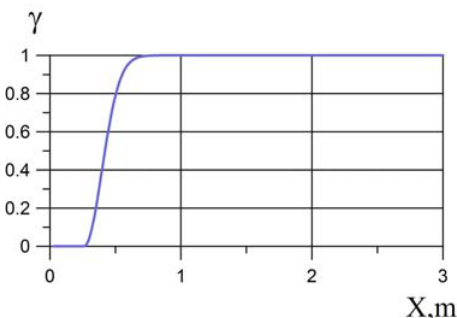
Figure 6 – Calculated dependence of the intermittency coefficient γ along the length of the tubular guide at the moment the projectile leaves the guide (the flow moves from left to right)